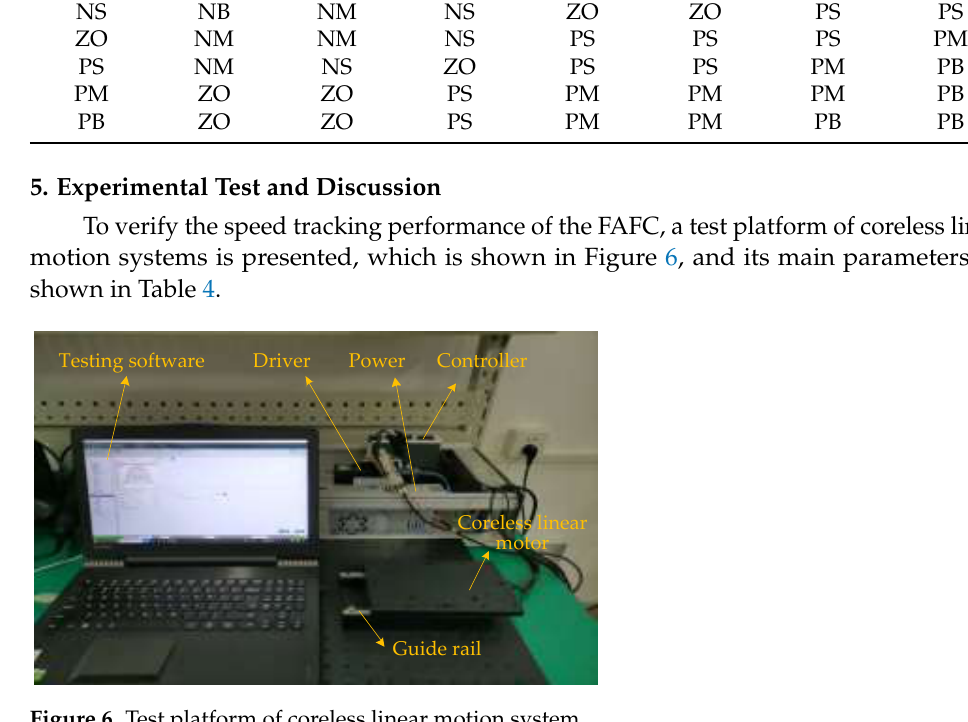
Table 4. Main parameters of motion system.